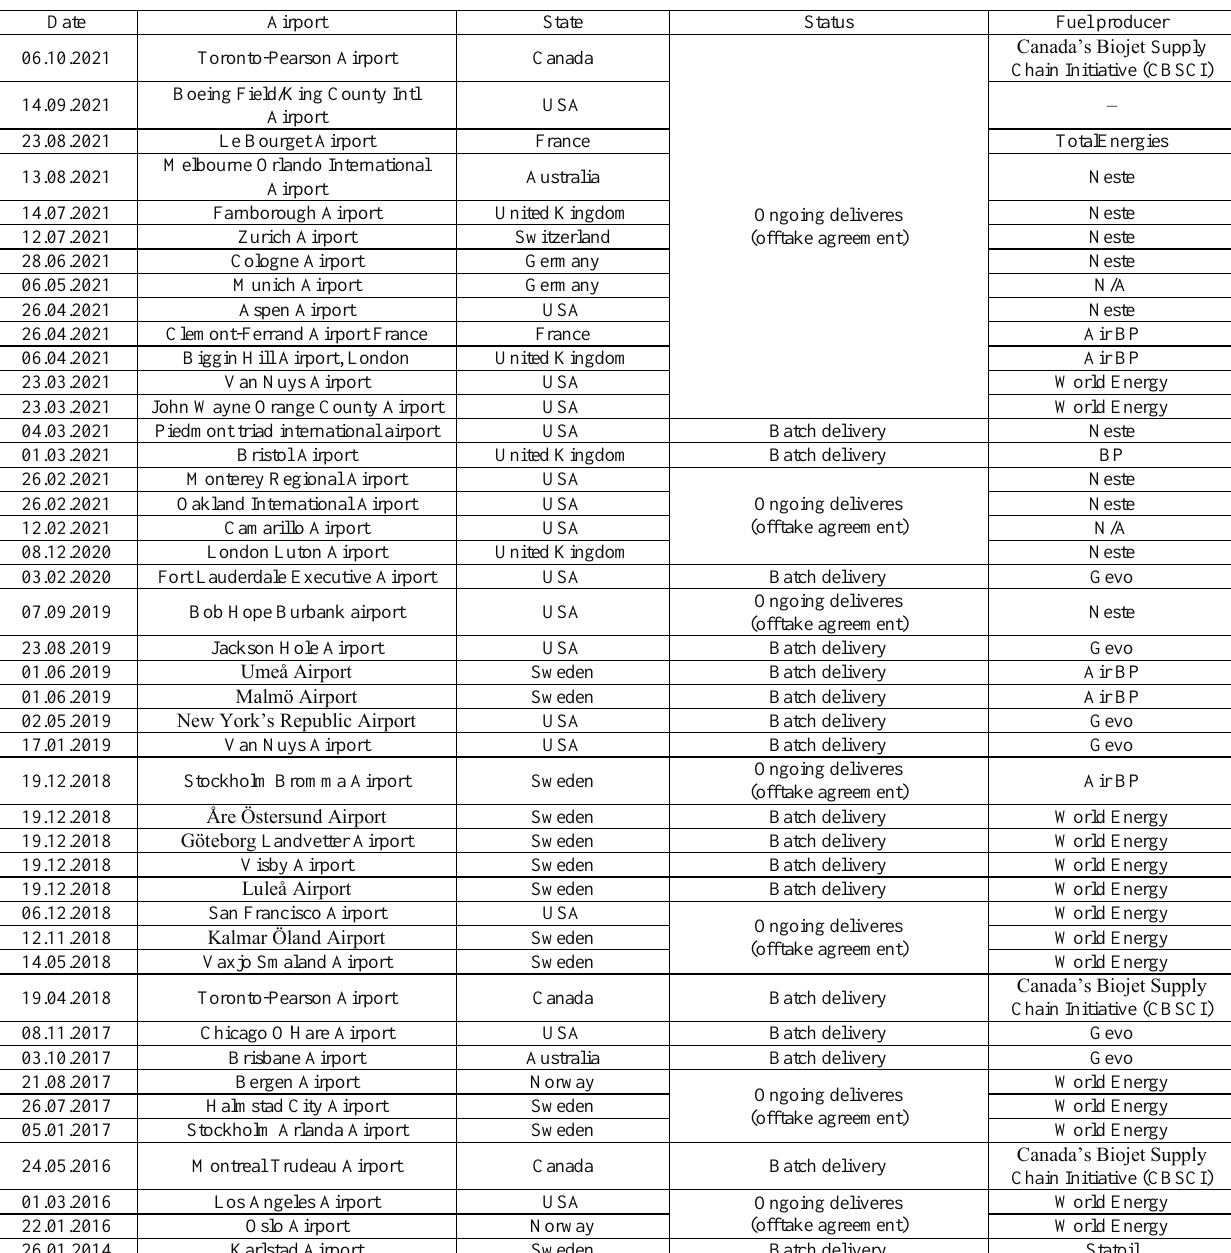
Table 3. List of airports distributing SAF [33]